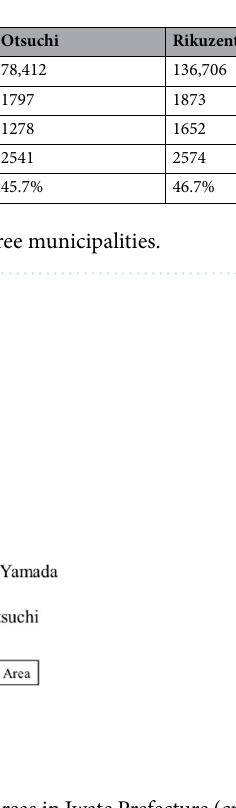
Figure 2. Map of the study area and secondary medical areas in Iwate Prefecture (created by MANDARA version 9.4.1. http:// ktgis. net/ lab/ index. php). The black square shows the study area along the Pacific Ocean coast. The municipalities included in the study (Otsuchi, Rikuzentakata, and Yamada) are marked in dark gray. Secondary medical areas in Iwate Prefecture are shown by solid lines. Otsuchi, Rikuzentakata, and Yamada are included in Kamaishi, Kesen and Miyako medical areas,